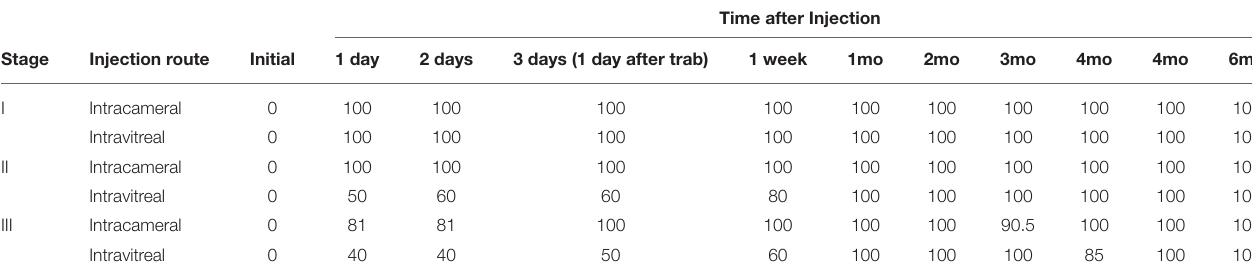
TABLE 4 | Regression rate (%) of NVI following conbercept injection.